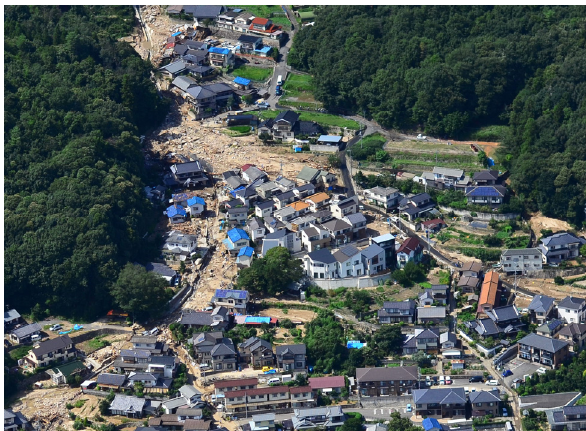
Figure 17. Asaminami Ward green well district (1).